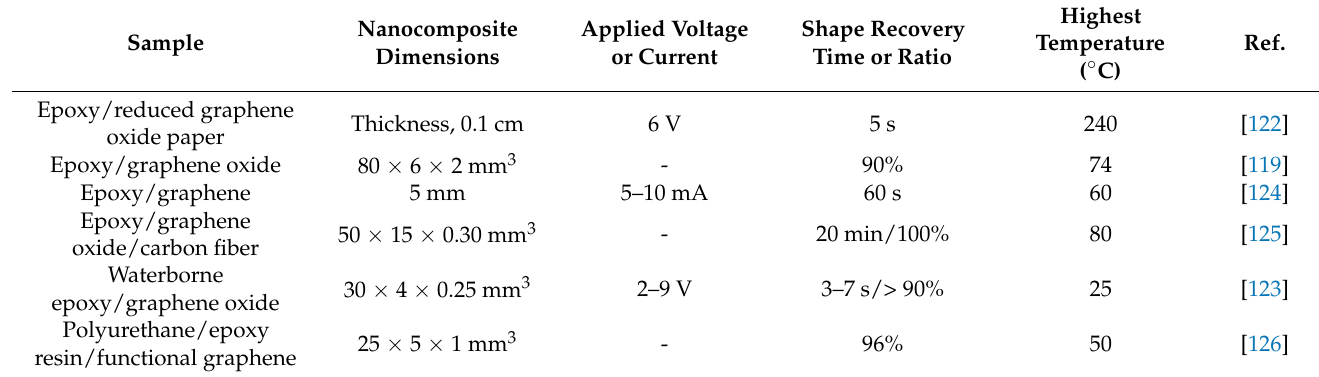
Table 2. Epoxy/graphene oxide or modified graphene oxide-based shape memory